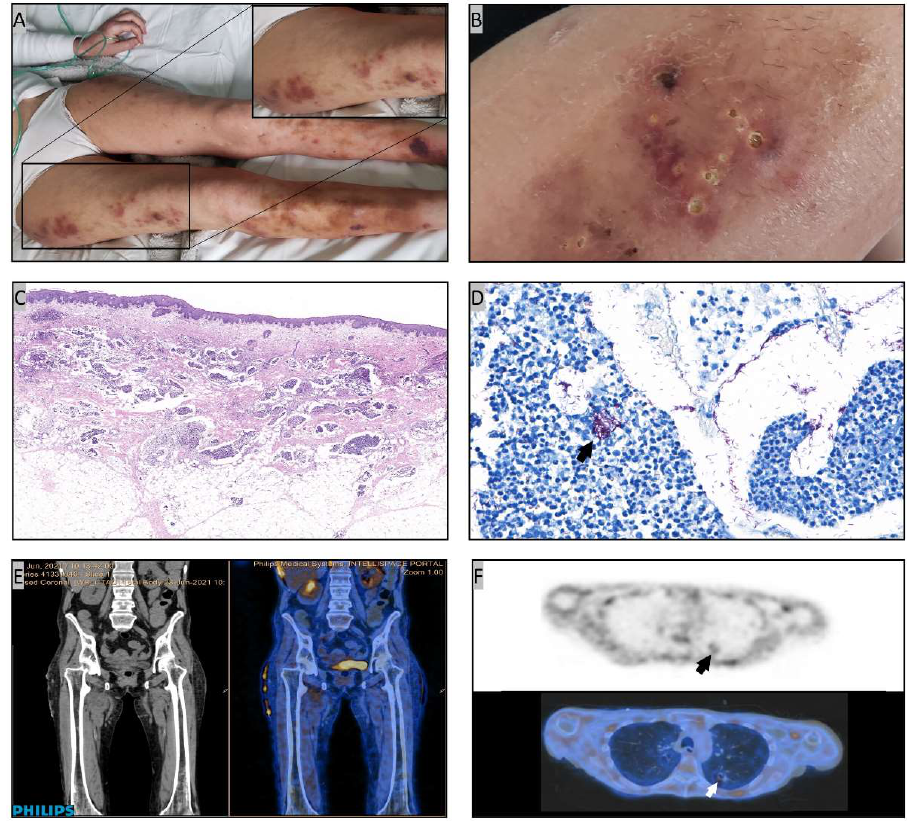
Figure 2. Overview of leg skin lesions with a detail of nodules on the right thigh ( A ), and photographic enlargement of abscessed lesions ( B ); histological analysis of skin biopsy evidencing a diffuse nodular suppurative inflammation with pseudocystic spaces involving the dermis and subcutis (Hematoxylin-eosin, original magnification ×8) ( C ), and abundant microorganisms (arrow) identifiable within the pseudocystic spaces by Ziehl-Neelsen staining (original magnification ×400) ( D ); FDG-CT/PET images showing an increased uptake at skin and soft tissues levels, with those of the right tight and sacrum presenting the maximum value (SUV 5.4) ( E ), and an increased uptake (arrow) in correspondence of lung lesions ( F